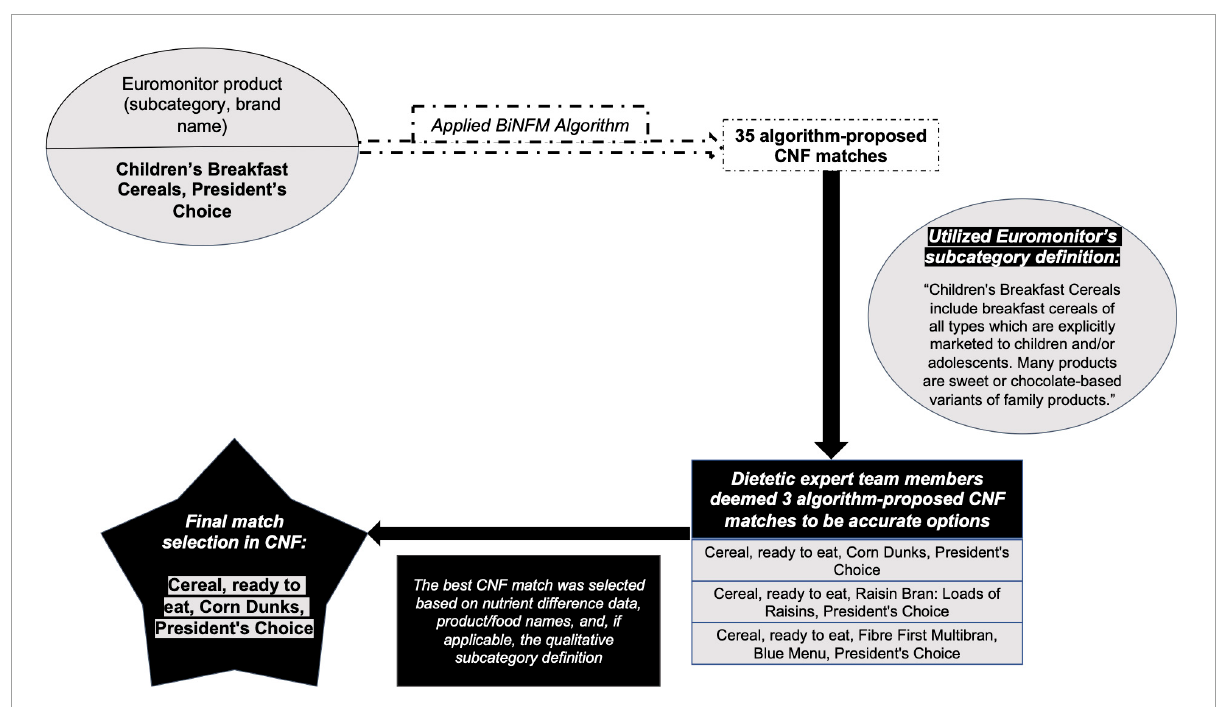
FIGURE4 Example of our algorithm-aided, dietetics expert-validated matching